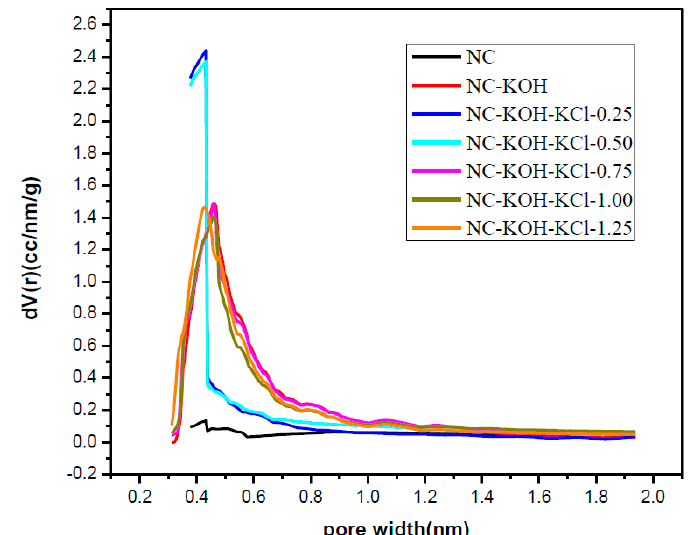
Figure 6. The micropore size distribution of samples activated by different amount of KCl and 1.2 g KOH per 2.20 g resorcinol.